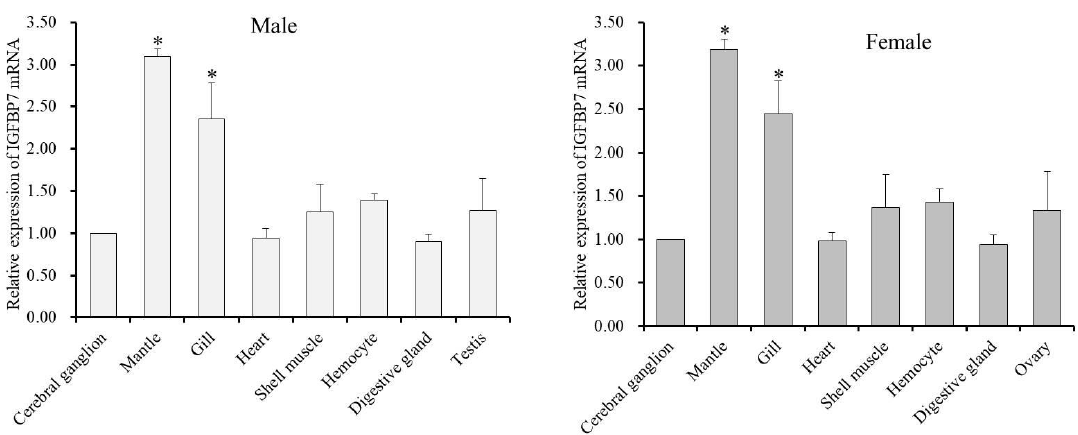
Figure 5. Comparison of 3D structure of IGFBP7 from ( A ) H. discus hannai and ( B ) H. madaka . N- and C- termini are marked with arrows. The structure was generated using I-TASSER server with a C-score between 2 and 4.